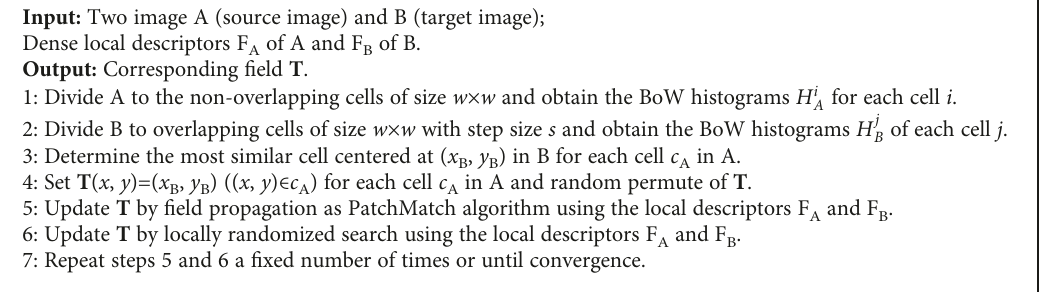
Algorithm 1: Hierarchically dense matching.